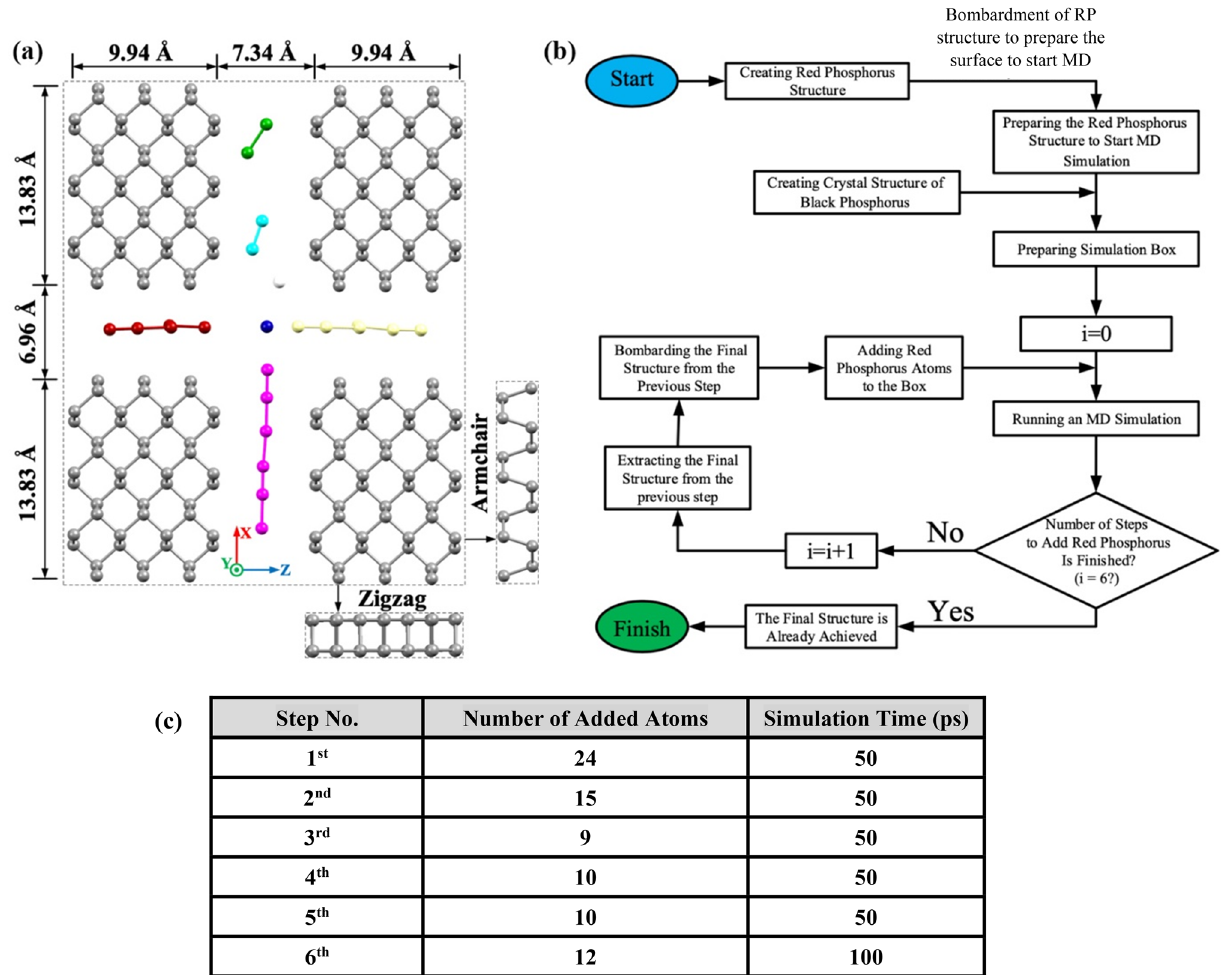
Figure 5. MD Simulation steps. ( a ) Initial arrangement of the system in the XZ plane to assess the directional preference during crystallization procedure. The side viewpoints of the BP blocks in zigzag and armchair directions are illustrated. The snapshots were rendered by Mercury 23 . ( b ) A schematic flowchart for the implementation of the modeling and simulation steps to investigate the directional preference in crystal growth. ( c ) Simulation details for different steps of adding RP